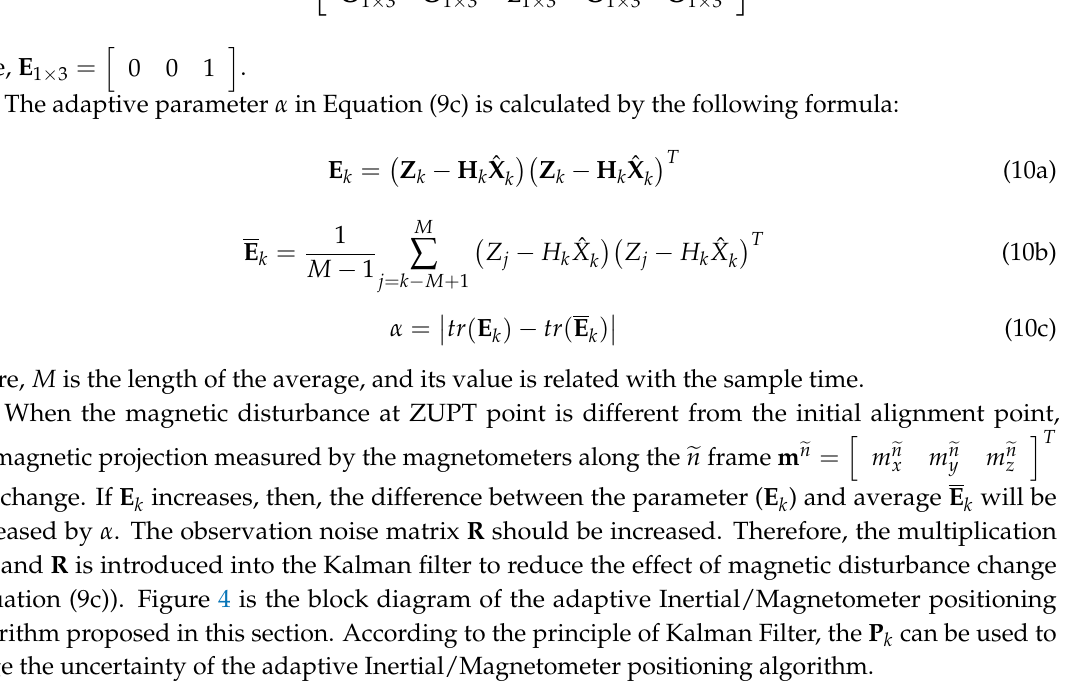
Figure 5. Schematic diagram of the improved algorithm for FIPPS.